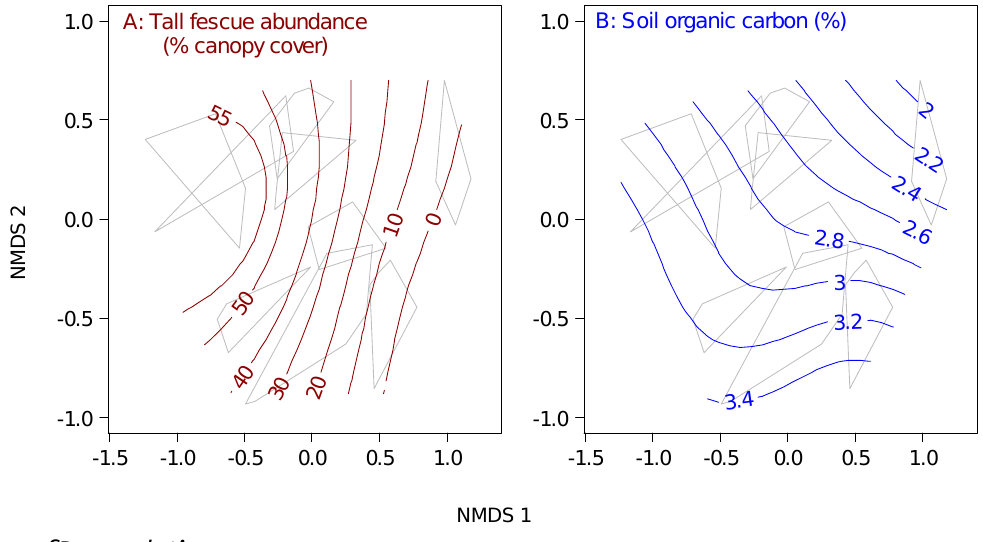
Figure 2. Fitted surfaces present gradients in tall fescue canopy cover ( A ) and soil organic carbon ( B ) across the ordination of vegetation data presented in Figure 1. Grey polygons connect six modified Whittaker sampling plots for each of nine sampled